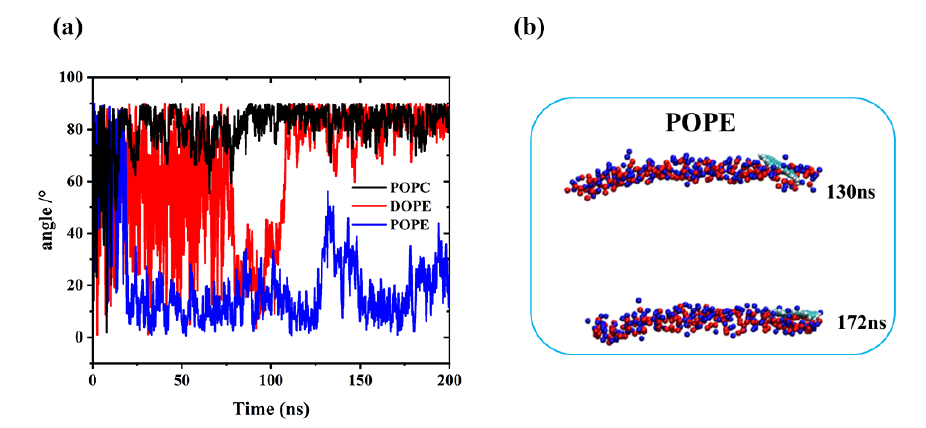
Figure 4. ( a ) Change in the plane angle between GQDs and the cell membrane during simulation. ( b ) Angle of GQDs on POPE cell membrane at 130 and 172 ns.